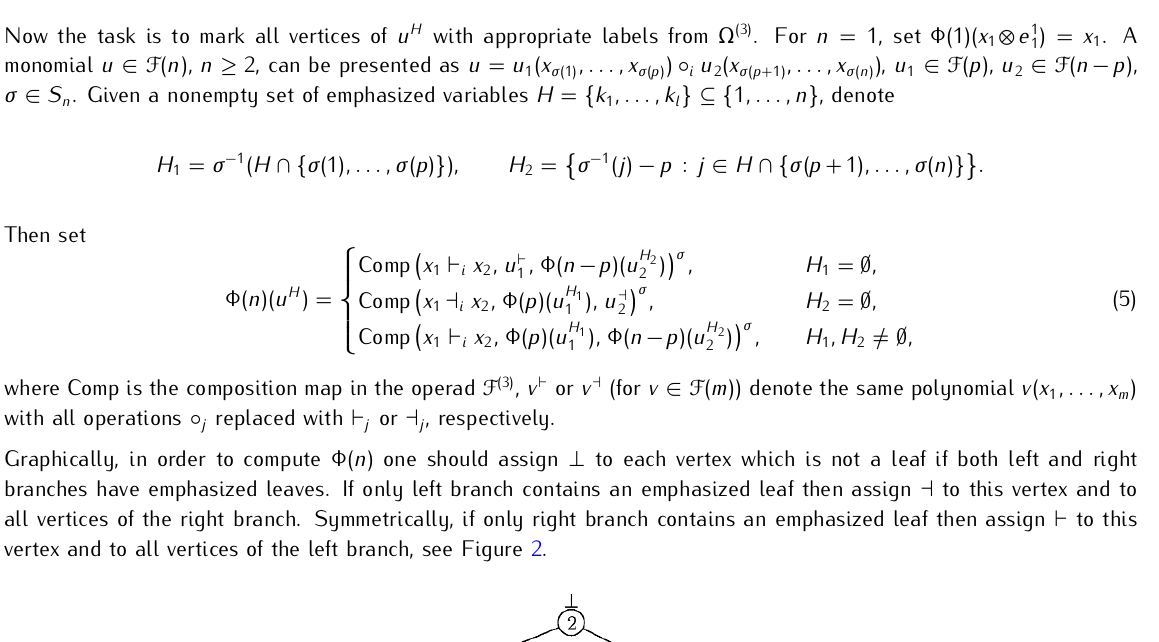
P α ξ u ξ ∈ F ( n ), ξ